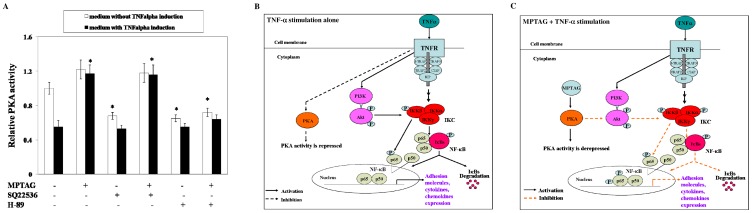
MPTAG restores PKA activity in TNFα-stimulated HUVECs.(A) The cells were treated with media (control), MPTAG, SQ 22536, H-89 or their indicated combinations in absence and presence of TNF-α stimulation. PKA activity was assessed in the cell lysates. Results are expressed as mean ± sem of three independent experiments. *p<0.05 vs. control. Proposed model of MPTAG action in TNF-α-stimulated HUVECs. (B) In TNF-α-stimulated HUVECs (without MPTAG treatment), PI-3K-regulated Akt is activated (indicated by solid line arrow) resulting in NF-κB activation. On the other hand, PKA activity remained repressed (indicated by broken line arrow) under these conditions. (C) MPTAG pretreatment to TNF-α-stimulated HUVECs restored the repressed activity of PKA. Thus, derepression of PKA activity resulted in inhibition of Akt and overall inhibition of NF-κB in these cells.